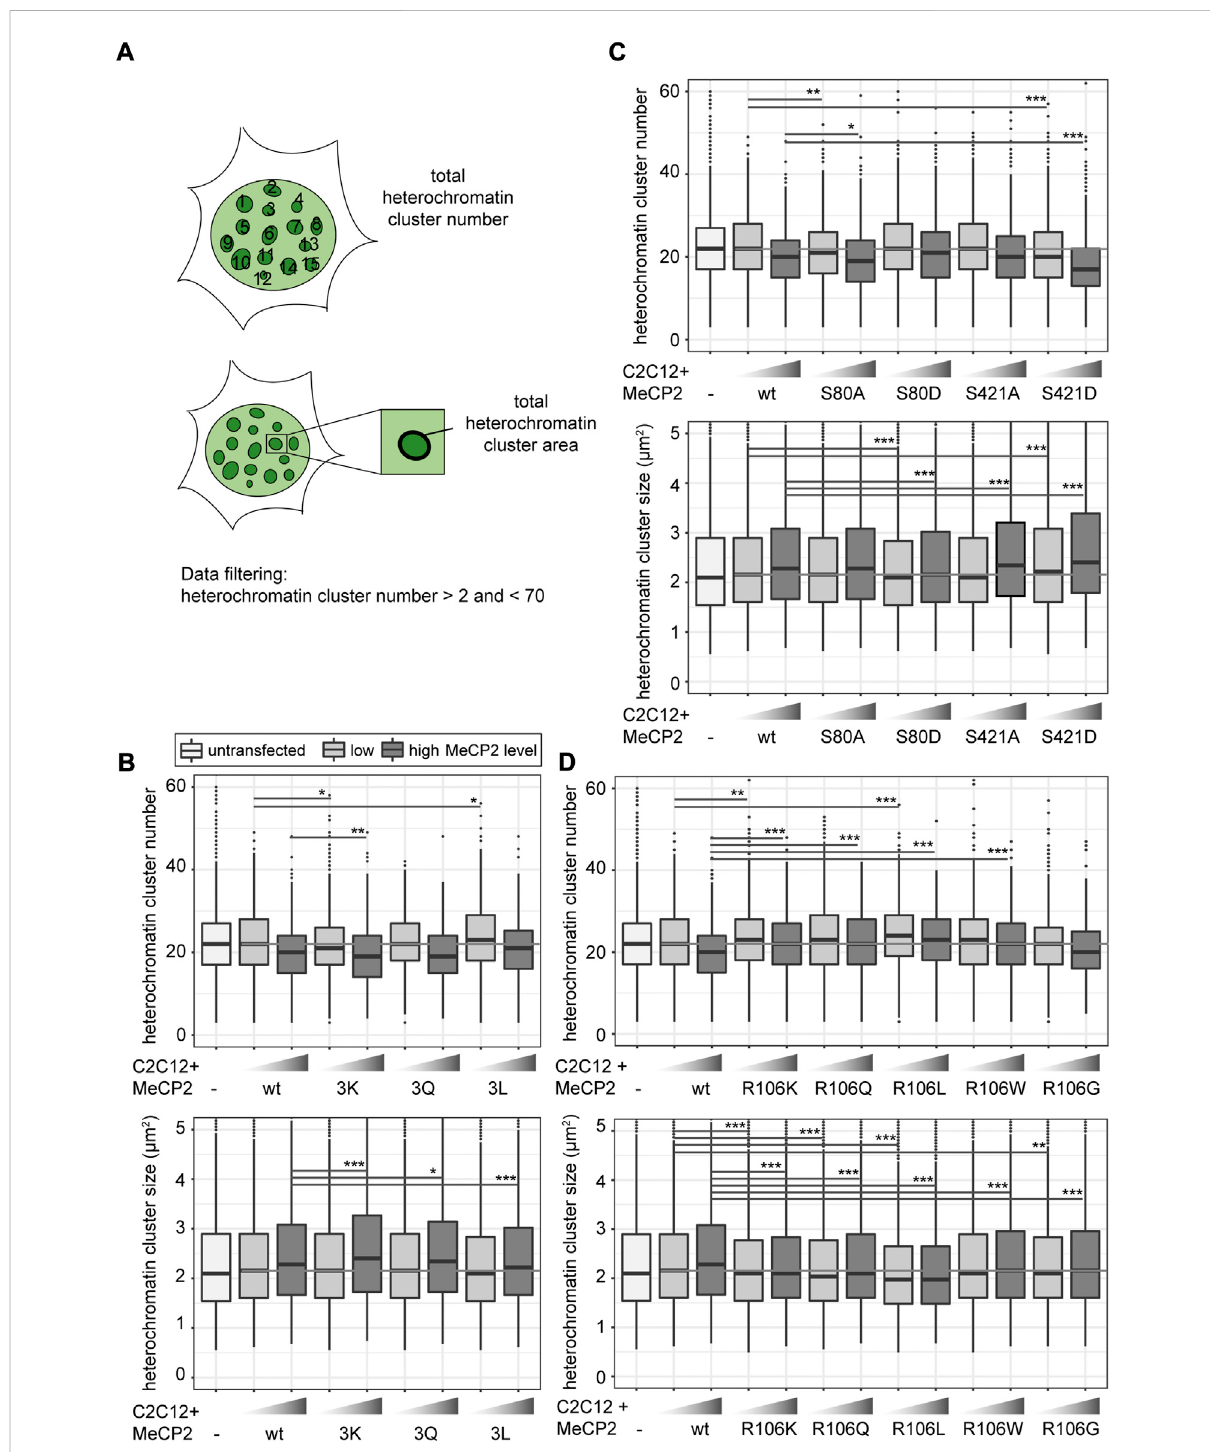
FIGURE 5 Heterochromatin clustering and cluster size of cells transfected with MeCP2 mutant constructs. Shown are the heterochromatin cluster numbers and areas scheme in (A) obtained for the arginine mutants including R91, R162, and R167 (B) , arginine R106 (D) and S80, S421 phosphorylation (C) mutant constructs in C2C12 cells from high-content screening microscopy after segmentation of nuclei and heterochromatin clusters. Cells were divided into low and high MeCP2 levels based on their nuclear GFP signal. Three biological replicates, statistical signi fi cance calculated using Wilcoxon-Rank test. * p < 0.05, ** p < 0.005, *** p < 0.001, n. s Not signi fi cant. p -values and n-values are summarized in Supplementary Table